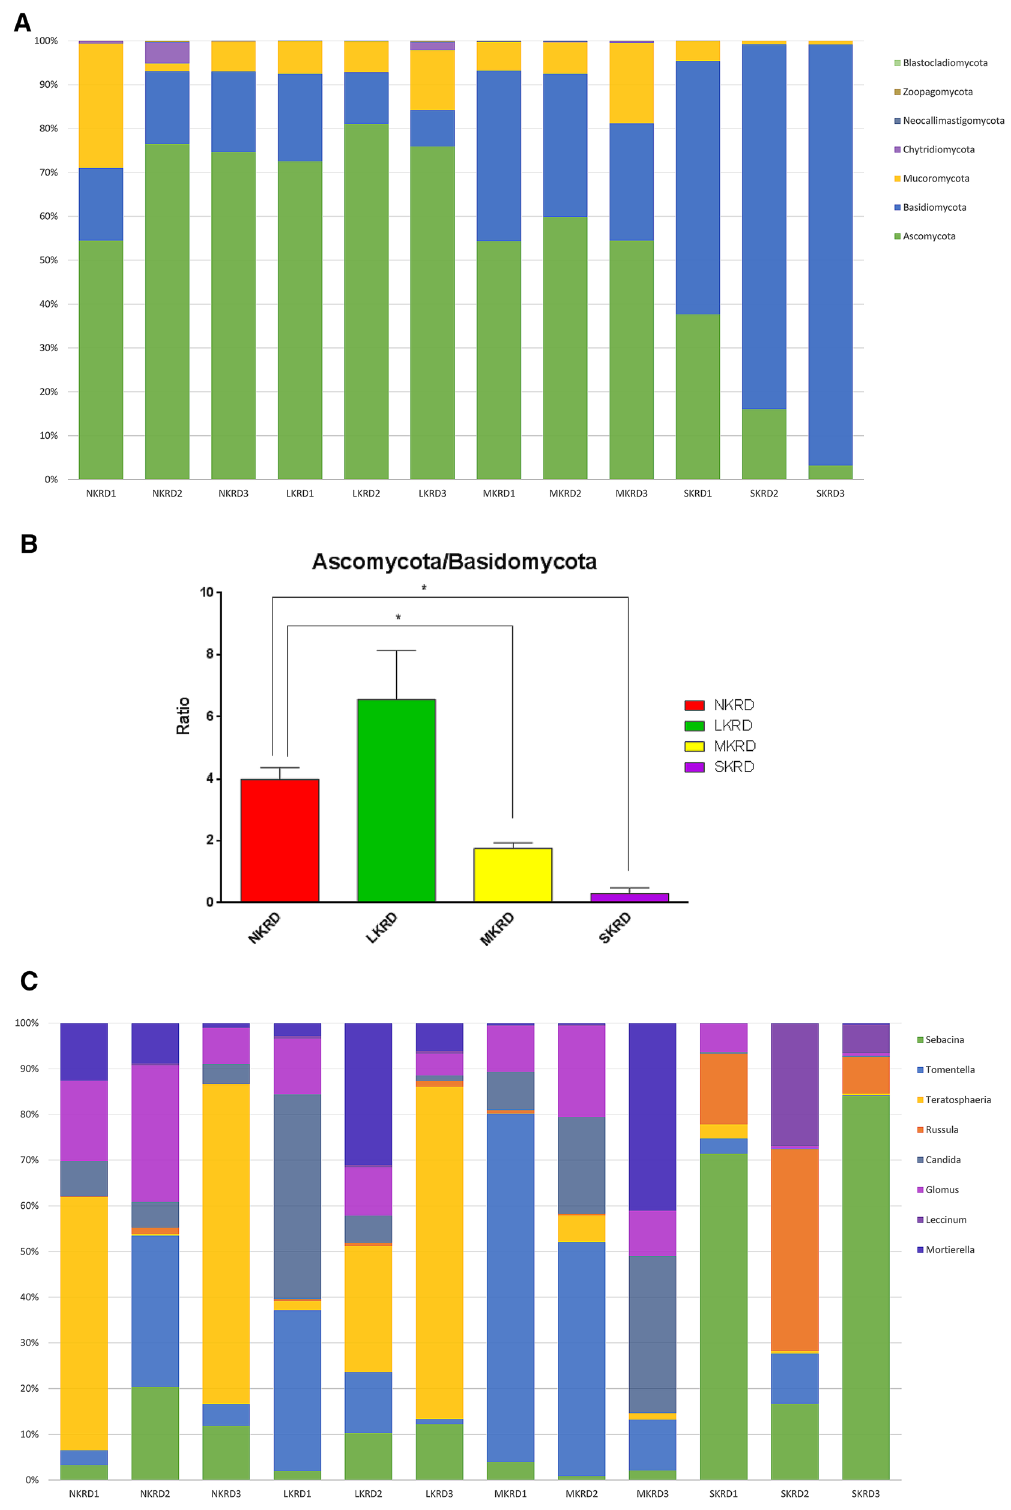
Figure 1. Relative abundance of fungi at phylum level ( A ), ascomycota/basidiomycota ratio ( B ), and core genera ( C ). The Tukey’s honest significant difference (HSD) test was used to determine the significance, * P < 0.05. No KRD (NKRD), latent KRD (LKRD), moderate KRD (MKRD), and severe KRD